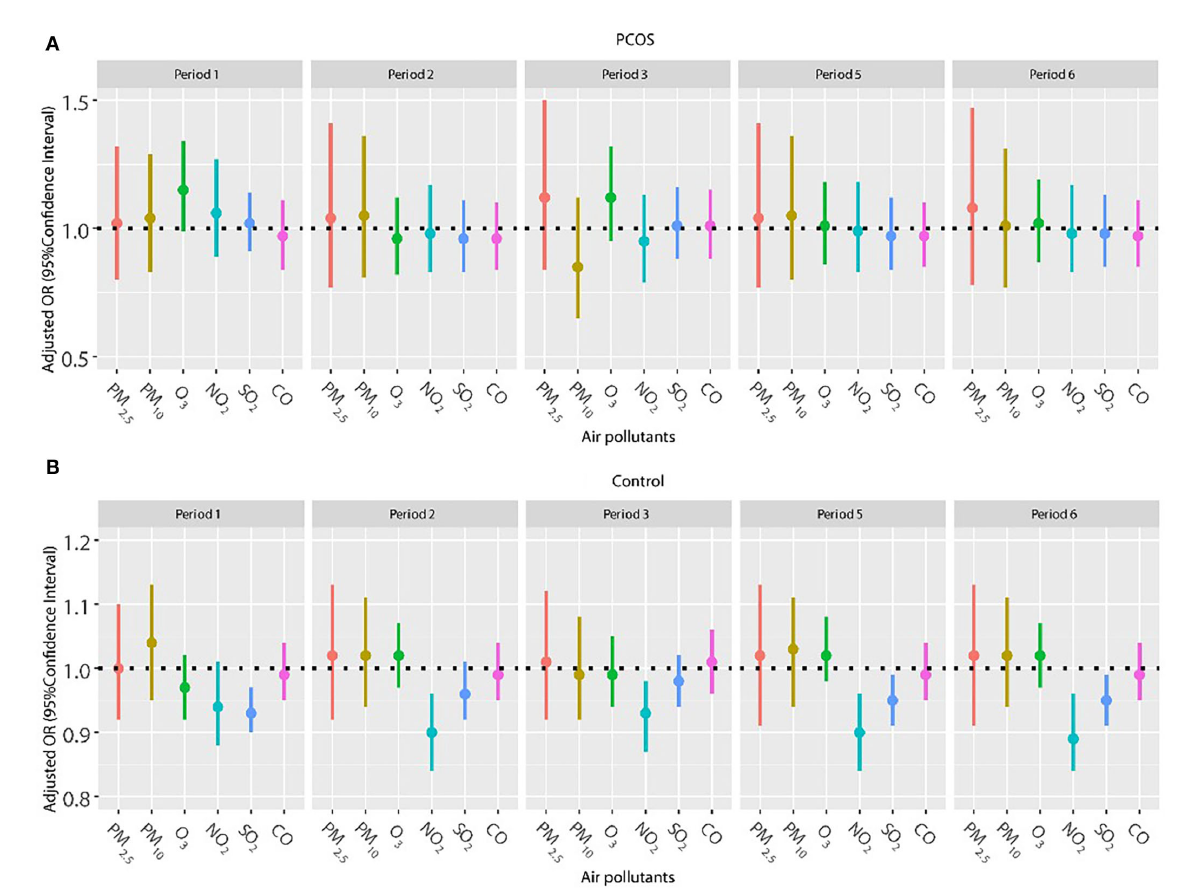
FIGURE3 (A,B) Association between ambient air pollution exposure and live birth rate among women with and without PCOS with frozen embryo transfer. Results showed in bold indicated statistically significant associations. PM 2.5 , particulate matter ≤ 2.5 µ m, µ g/m 3 ; PM 10 , particulate matter ≤ 10 µ m, µ g/m 3 ; NO 2 , nitrogen dioxide, µ g/m 3 ; SO 2 , sulfur dioxide, µ g/m 3 ; CO, carbon monoxide, mg/m 3 ; O 3 , ozone, µ g/m 3 . Model adjusted for patients’ age ( < 30, 30–34, 35–39, and ≥ 40 years), BMI, education level, infertility type (primary or secondary infertility), infertility duration, infertility cause (female factor, male factor, both, and unexplained factor), number of embryos transferred (one or two), fertilization method (IVF, ICSI, or IVF + ICSI), endometrial thickness, and season of embryo transfer (spring, summer, autumn, or winter). Periods 1, 2, 3, 5, and 6 indicate the exposure windows shown in Figure